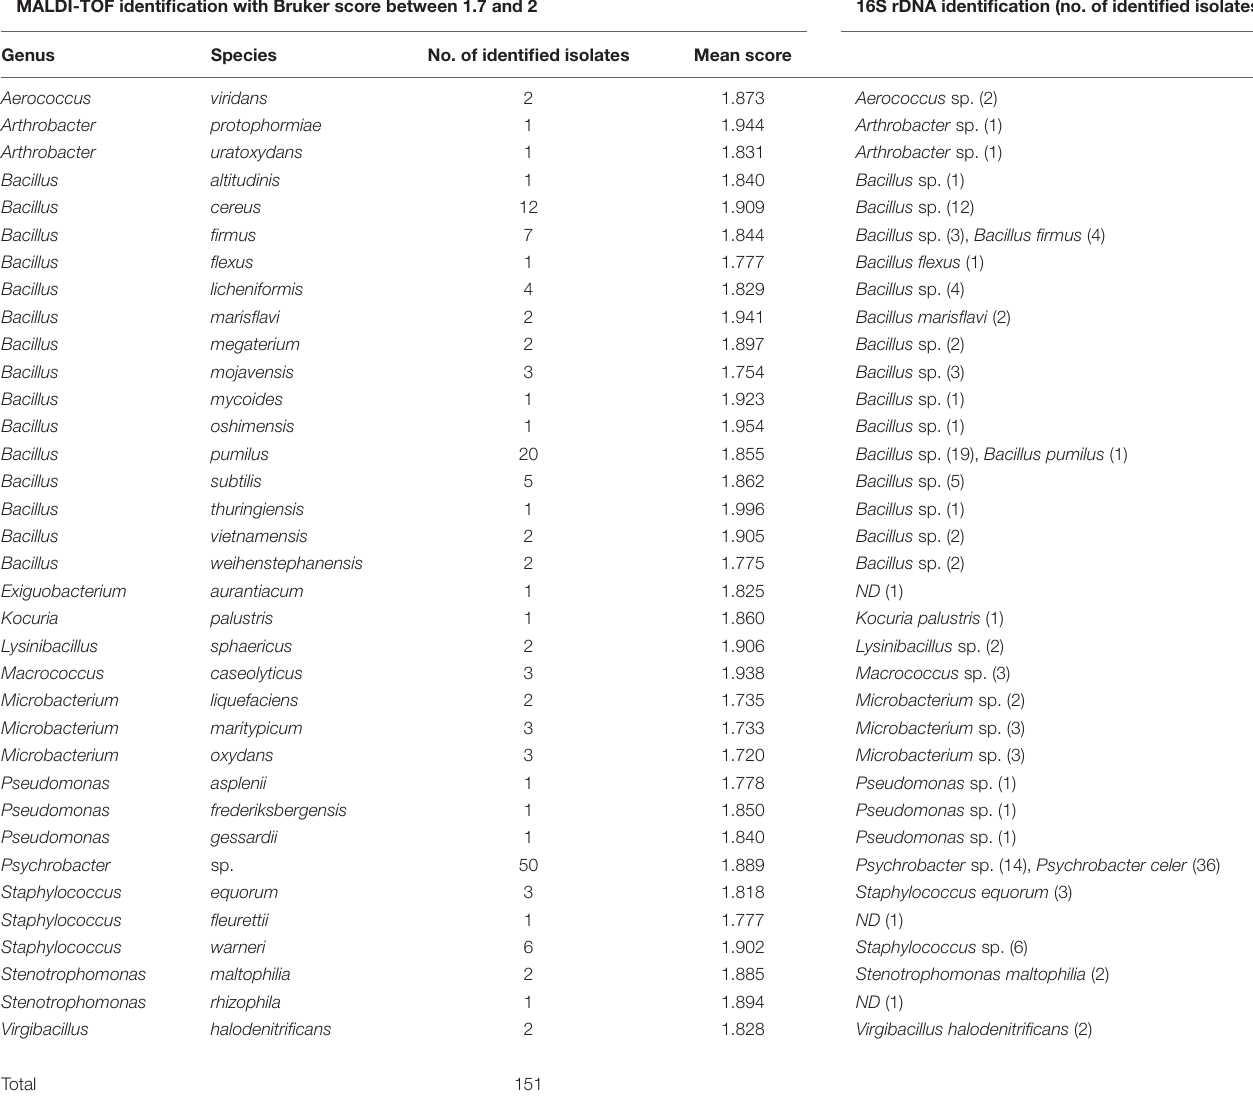
TABLE 2 | Identification of isolates by 16S rDNA technique and by MALDI TOF method with Bruker between 1.7 and 2. MALDI-TOF identification with Bruker score between 1.7 and 2 16S rDNA identification (no. of identified